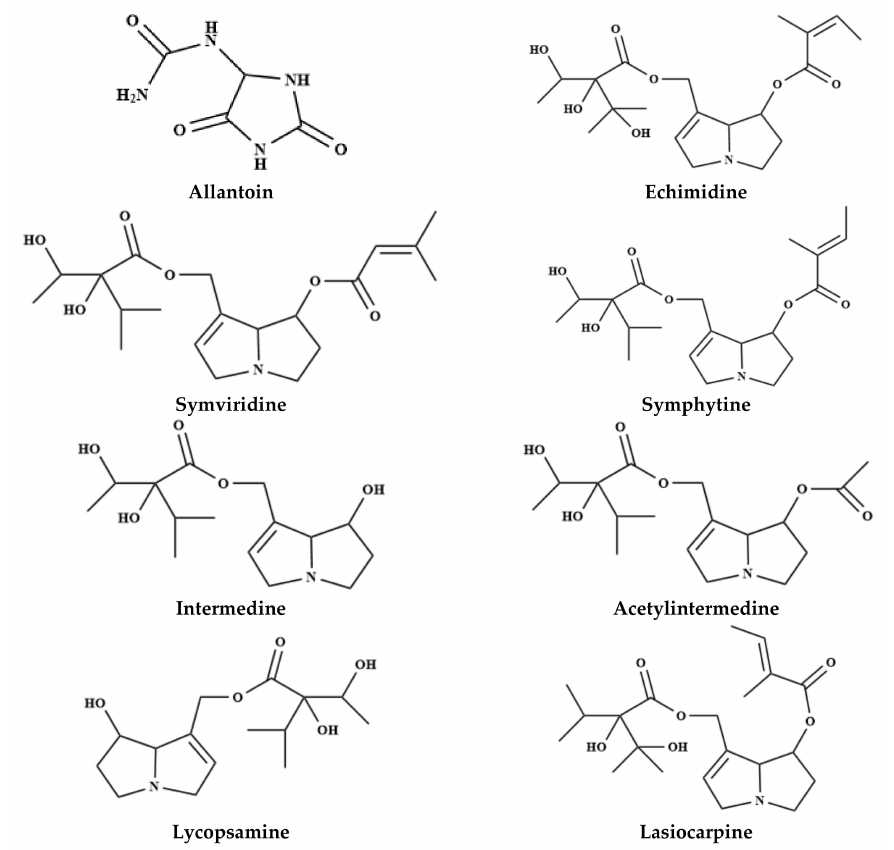
Figure 1. Chemical structure of the main heterocyclic compounds of the Symphytum